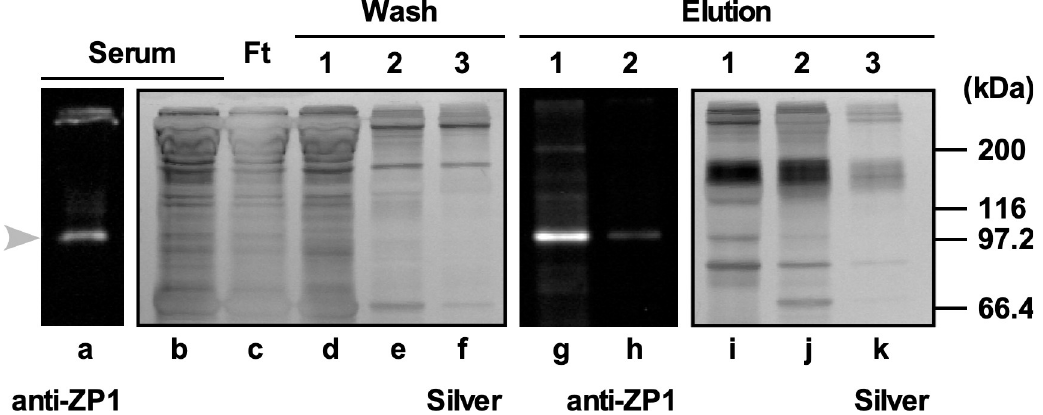
Fig 5. Selective immobilization of chicken ZP1 on nickel-affinity magnetic beads. To establish a method to immobilize native chicken ZP1 on the carrier beads under mild conditions, the binding capacity of chicken ZP1 containing plenty of His residues for the nickel-affinity magnetic beads was confirmed. The nickel-affinity magnetic beads were incubated with the laying-hen serum, and after washing, the proteins being bound to the beads were eluted with the imidazole-containing buffer. The results of non- reducing SDS-PAGE followed by the silver staining ( lanes b–f and i–k) and immunoblotting using the anti-ZP1 antiserum ( lanes a, g and h) for the serum ( lanes a and b, labeled as "Serum"), the flow-through fraction ( lane c, labeled as "Ft"), the wash fractions 1–3 ( lanes d–f, labeled as "Wash") and the elution fractions 1, 2 and/or 3 ( lanes g–k, labeled as "Elution") are shown. The migration position of the monomer of ZP1 is shown on the left side of lane a ( gray arrowhead ), and that of the MW markers are shown on the right side of lane